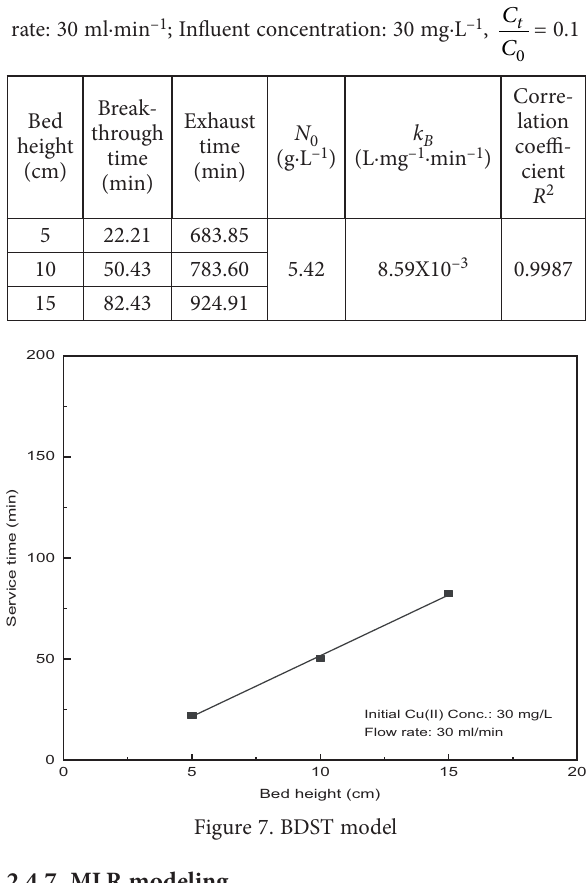
Table 6. Regression analysis of service time vs. bed height. Flow